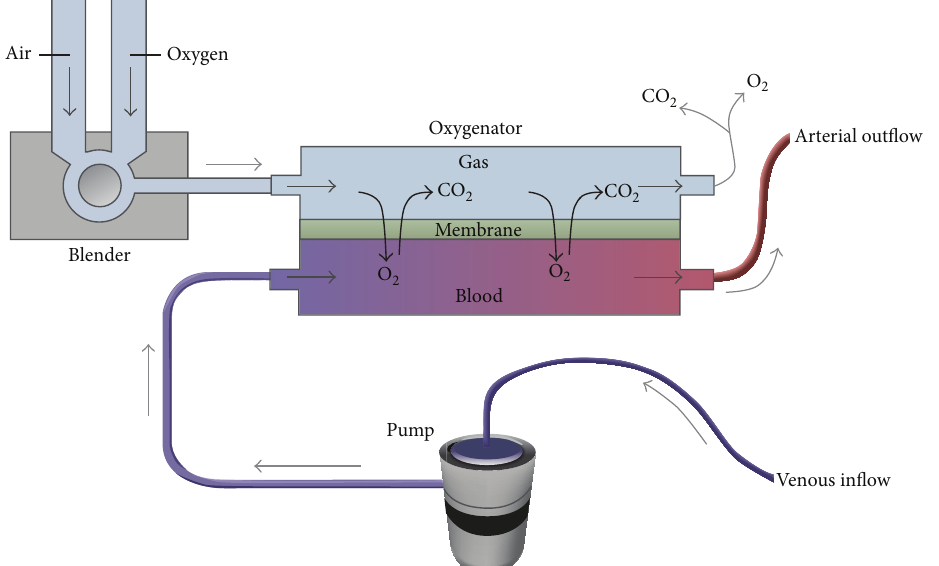
Figure 3: The oxygenator (also known as the membrane lung) is divided into a blood compartment and a gas compartment by a semipermeable membrane. The pump propels venous blood into the oxygenator and gas exchange occurs across the membrane as the blood interacts with fresh gas. After oxygenation and carbon dioxide removal, the arterialized blood is returned to the patient through an artery. A blender allows for adjustment of the fraction of delivered oxygen (F D O 2 ). From [4]. Copyright © (2011) Massachusetts Medical Society. Reprinted with permission from Massachusetts Medical